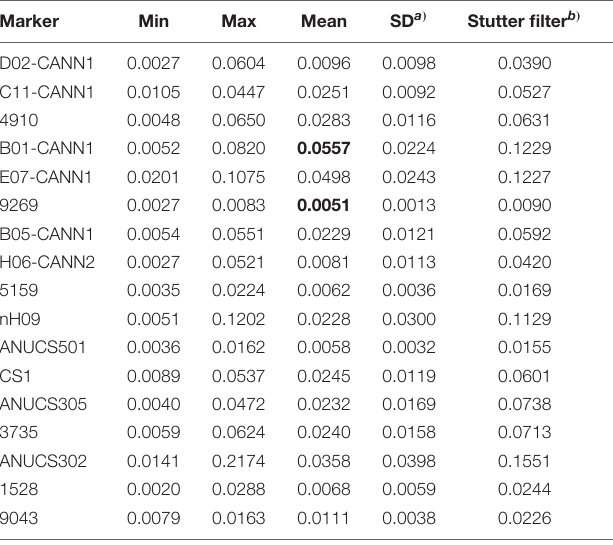
TABLE 2 | Stutter analysis for 17 STR loci of the Cannabis sativa 19-plex typing